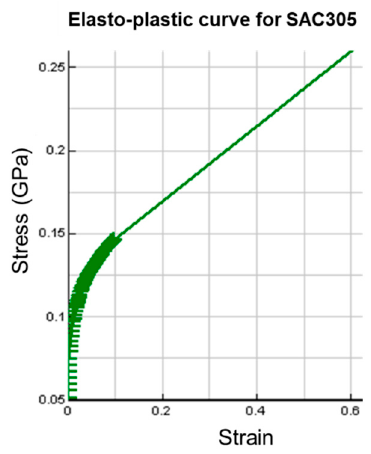
Figure 11. Stress-strain curve for SAC305 at high strain rate (drop shock).